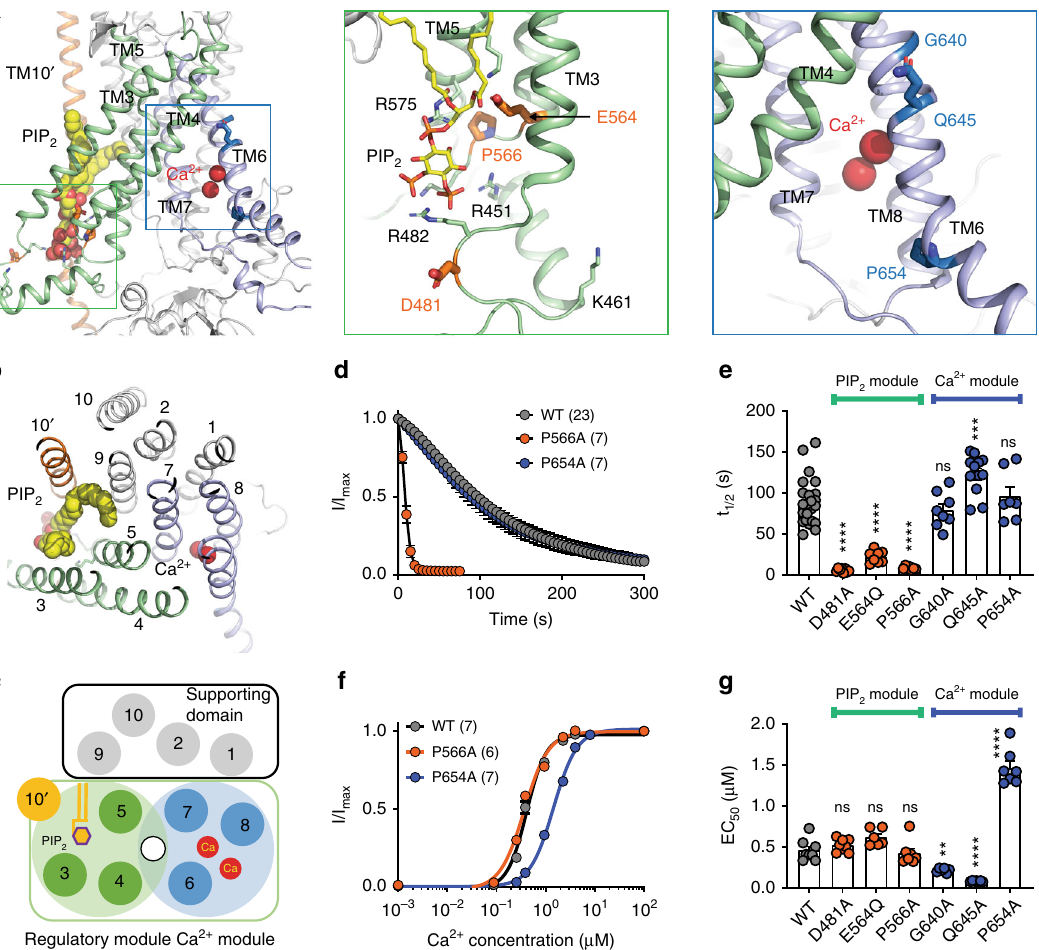
Fig. 5 Two functionally and structurally distinct modules in TMEM16A. Side view ( a ) and top view ( b ) of a TMEM16A monomer with a docked PIP 2 (yellow and orange spheres) binding to TMs 3 – 5 (green) and Ca 2 + (red spheres) binding to TMs 6 – 8 (purple). The numbers mark TM segments from one subunit and TM10 from the second subunit (10 ′ ). D481 and R482 residues (marked with an asterisk) belong to the unresolved 21-amino acid loop that was modeled into the structure. c A schematic representation of the “ two-module ” design of TMEM16A ion permeation pore (top view). The PIP 2 -binding regulatory module (TMs 3 – 5) and the Ca 2 + -binding module (TMs 6 – 8) are shown in pale green and light purple, respectively. A supporting domain composing of TMs 1, 2, 9, and 10 is shown in gray. The anion permeation pathway (indicated by an un fi lled circle) is formed between the Ca 2 + and PIP 2 modules. TM10 from the neighboring subunit (10 ′ ) is colored in orange. d Average normalized currents of TMEM16 WT, P566A, and P654A under 100 µ M Ca 2 + . e Comparisons of the half decay time ( t 1/2 ) of D481A, E564Q and P566A (thick orange sticks in a ) and G640A, Q645A and P654A (thick blue sticks in a ). f Ca 2 + dose-response curves of TMEM16A WT, P566A, and P564A. g Comparisons of the apparent Ca 2 + sensitivities of G640A, Q645A and P654A of the Ca 2 + module and D481A, E564Q, and P566A of the PIP 2 module. One-way ANOVA with Bonferroni ’ s multiple comparisons test: p -values are <0.0001 for D481A, <0.0001 for E564Q, >0.0001 for P566A, >0.9999 for P654A, >0.9999 for G640A, 0.0006 for Q645A in e ; >0.9999 for D481A, 0.1342 for E564Q, >0.9999 for P566A, <0.0001 for P654A, 0.0043 for G640A, <0.0001 for Q645A in g . Numbers in parentheses denote the number of individual recordings. Data are mean ± s.e.m. ns, not signi fi cant. Source data are provided as a Source Data fi